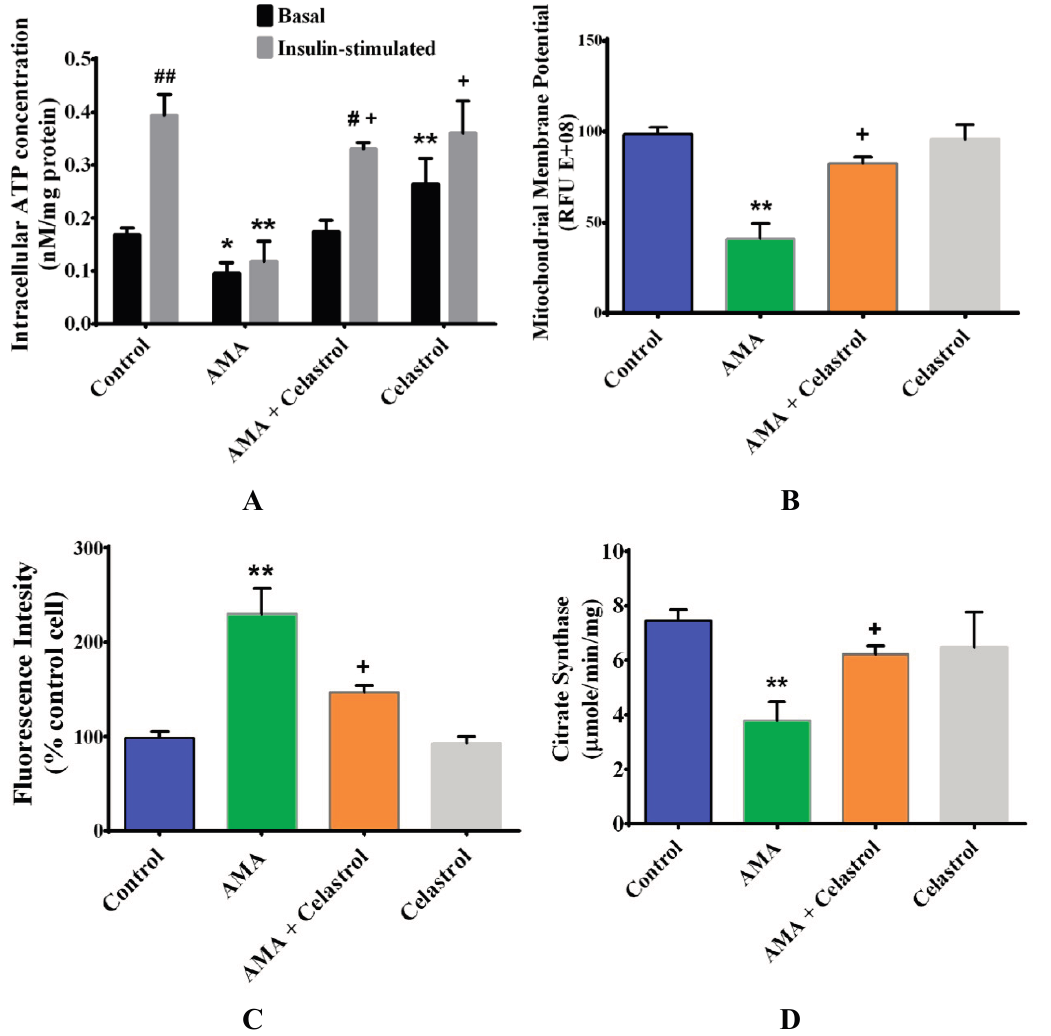
Figure 3. AMA and celastrol treatment of mitochondrial functions of skeletal muscle cells. After incubation, cells were assayed to measure intracellular ATP concentration ( A ), mitochondrial membrane potential ( B ), mitochondrial superoxide production ( C ) and citrate synthase activity ( D ). Basal and insulin-stimulated levels were shown. Basal rate refers to the rate of glucose transport in the absence of insulin. * p < 0.05 and ** p < 0.01 vs . untreated control; # p < 0.05 and ## p < 0.01 vs . basal rate; + p < 0.05 vs. AMA-treated